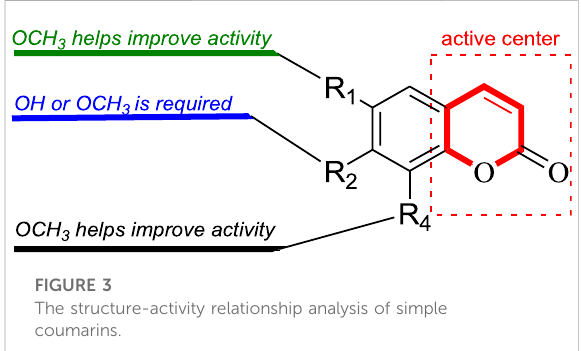
FIGURE 3 The structure-activity relationship analysis of simple